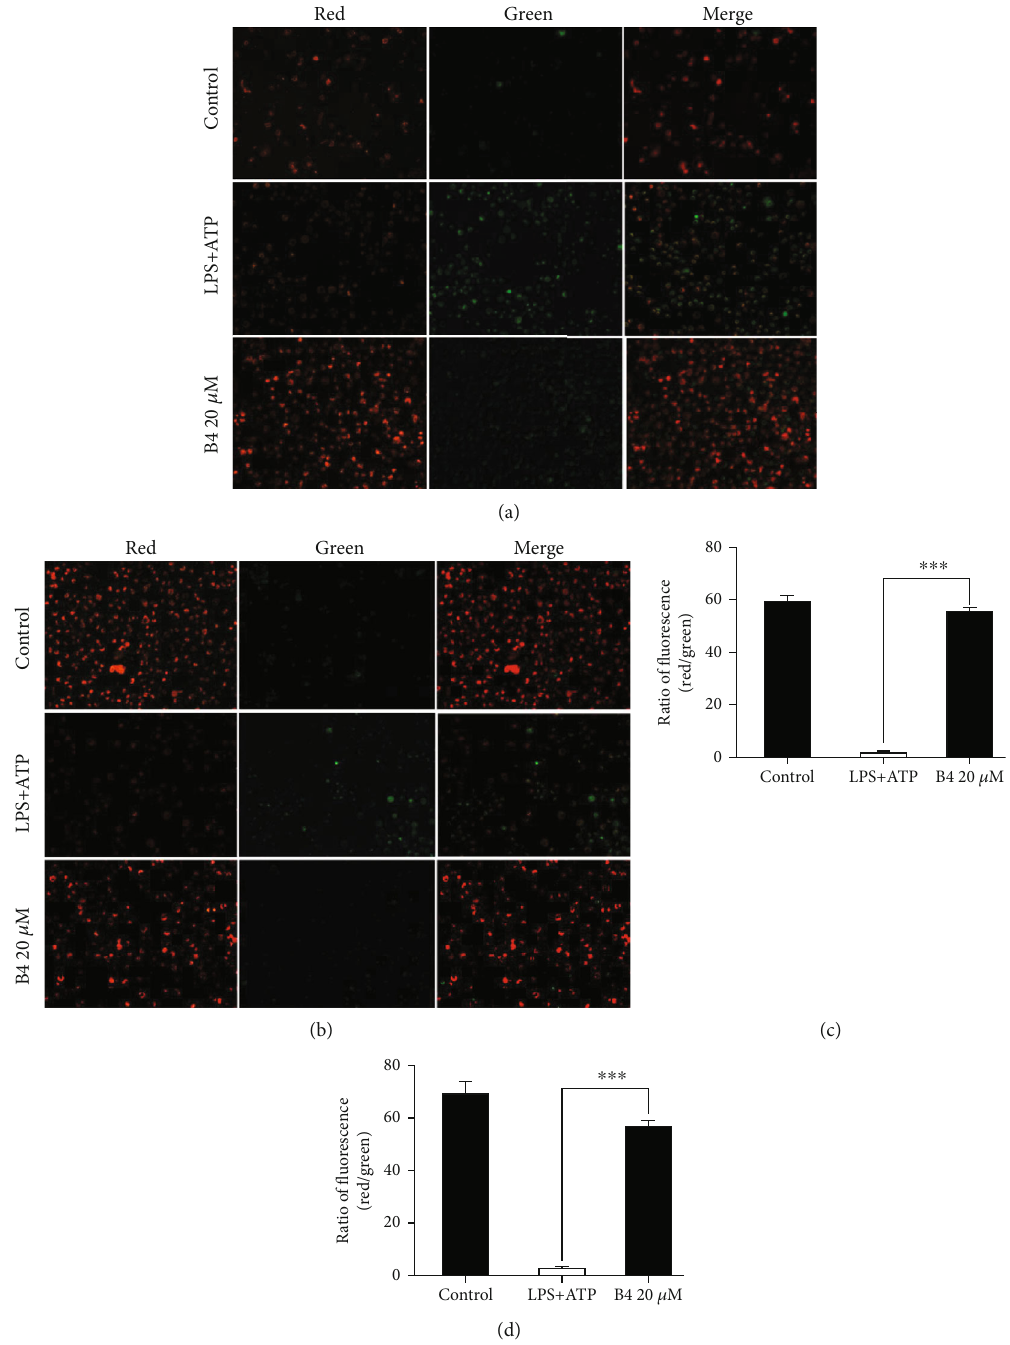
Figure 3: B4 suppressed the dysfunction of MMP in LPS plus ATP-stimulated macrophage cells. (a, b) J774A.1 cells and THP-1 cells were pretreated with B4 for 4h, then cocultured with LPS (1 μ g/mL) for another 5h, and stimulated with ATP (5 mM) for 30 min. The MMP levels were detected with JC-1 (10 μ g/mL) for 30min in an incubator in the dark. The images were captured by fl uorescence microscopy. (c, d) The ratio of red fl uorescence compared with green fl uorescence in (a) and (b) was analyzed statistically by ImageJ; ∗∗∗ P < 0 : 001 compared to the LPS+ATP